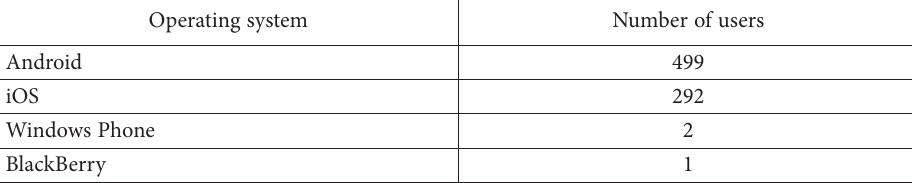
Table 3. Number of users by mobile operating system (source: created by